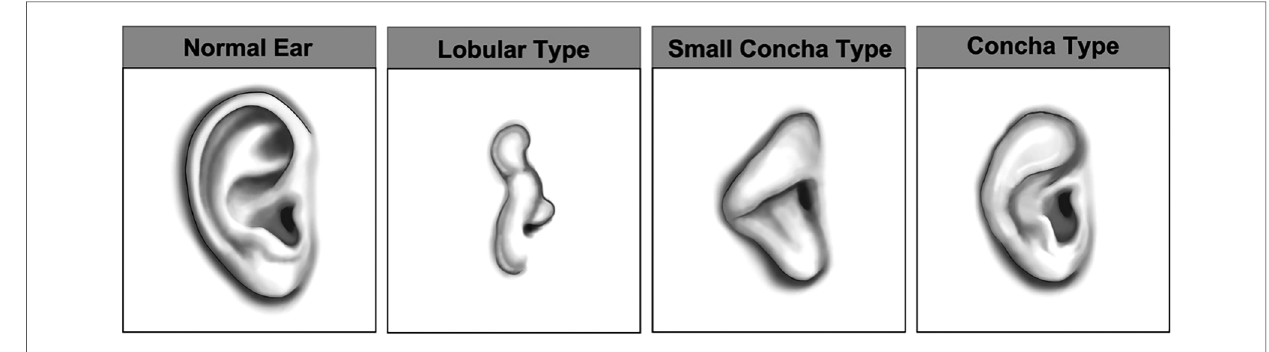
FIGURE 1 Nagata classi fi cation of auricular anomalies. Images kindly provided by Steve Atherton, Medical Illustration Department, Morriston Hospital,